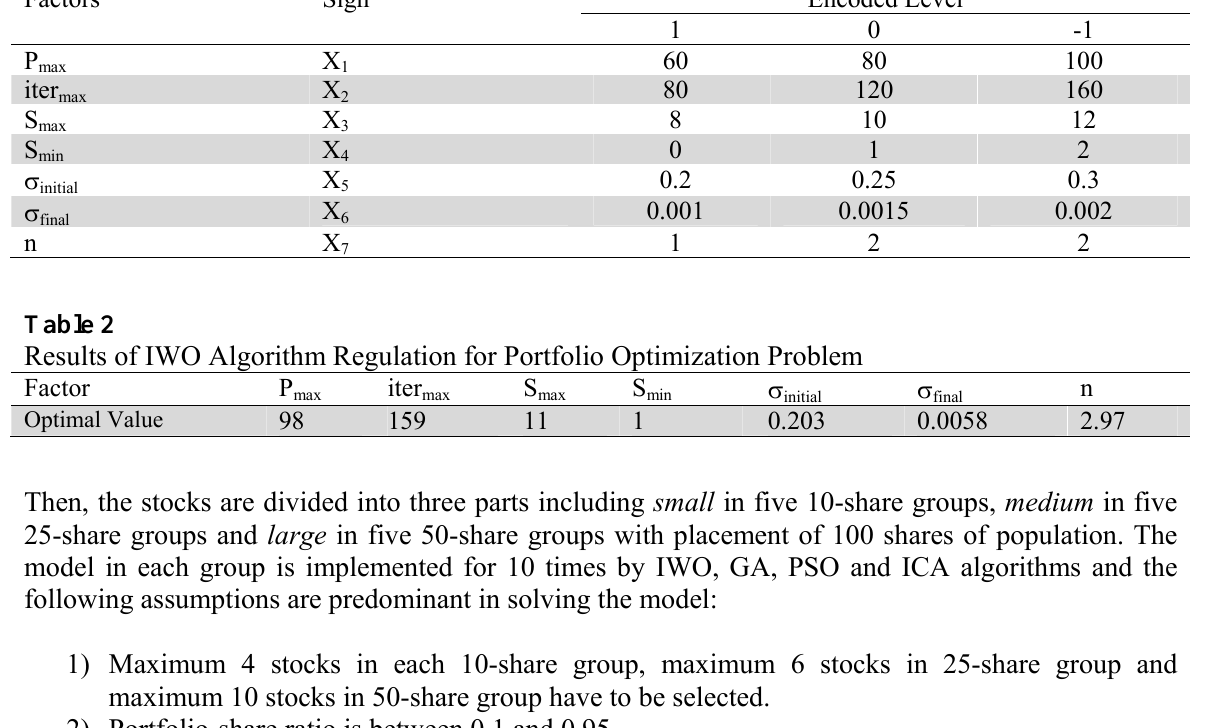
Limitations Given to Expert Design Software Factors